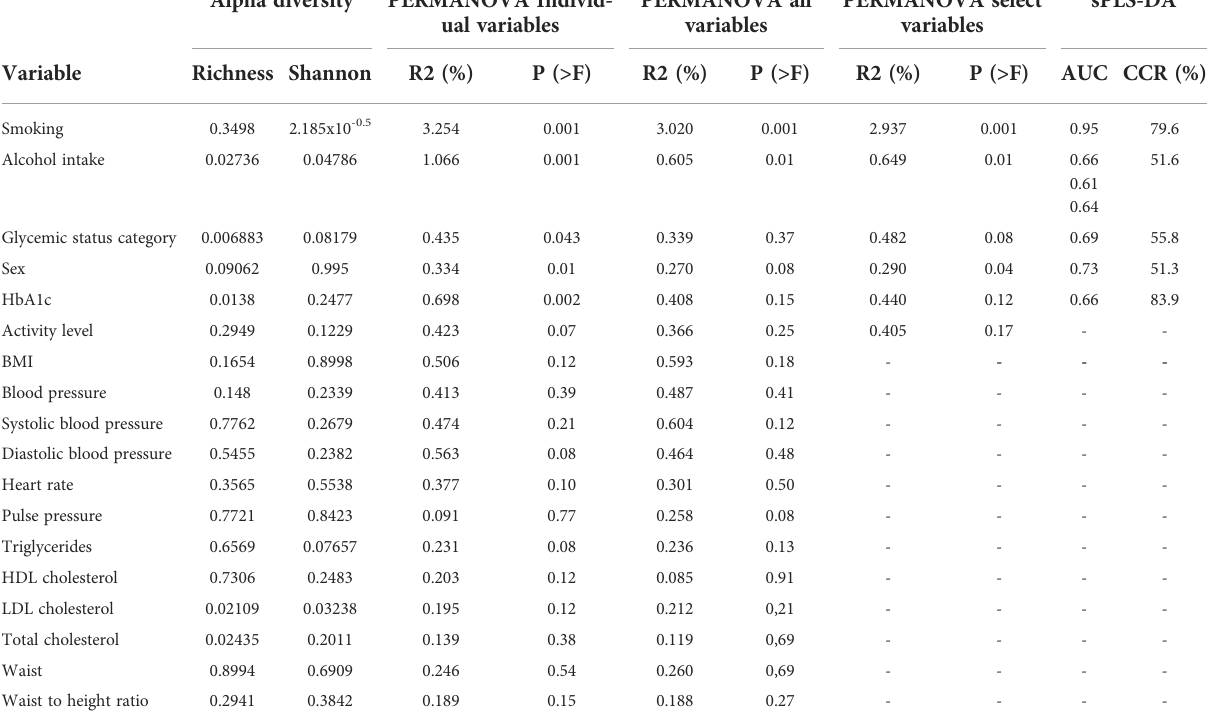
TABLE 2 Alpha diversity by Shannon index and